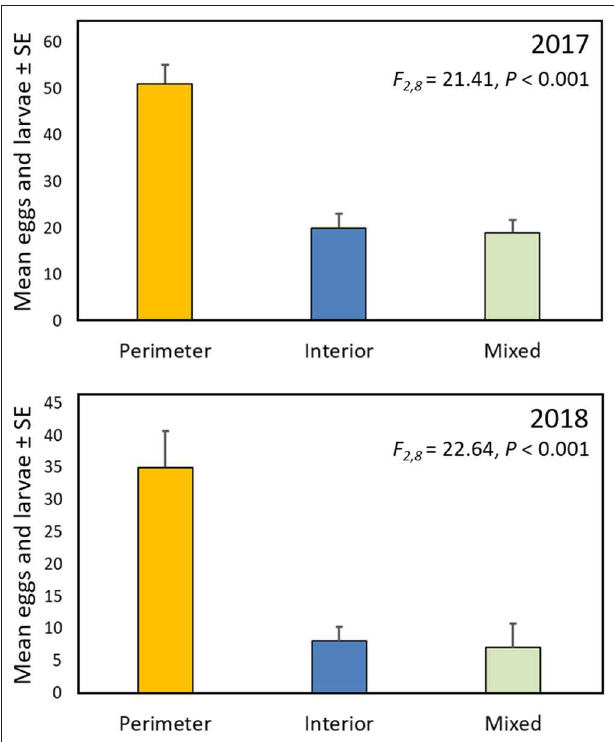
FIGURE 3 | Mean ( ± SE) total monarch eggs and larvae per garden for the three garden designs described in Figure 1 .